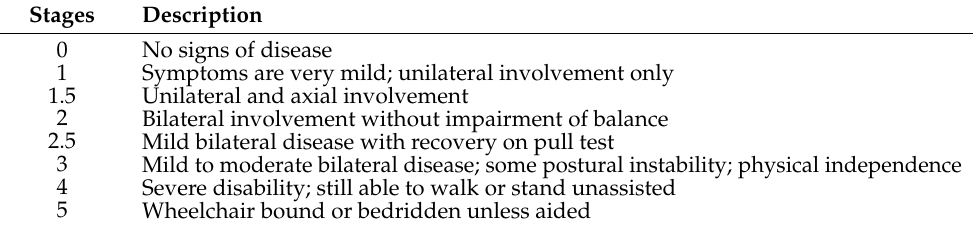
Figure 1. Description of beginning and ending of different gait phases in a normal gait cycle (Arafsha et al. [9]). Table 1. Hoehn and Yahr (HY) scale [10] for PD severity